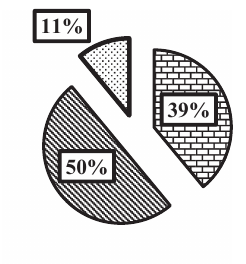
Figure 2. Statusofmunicipalities based on Brown ’ s Ten- Point Test result